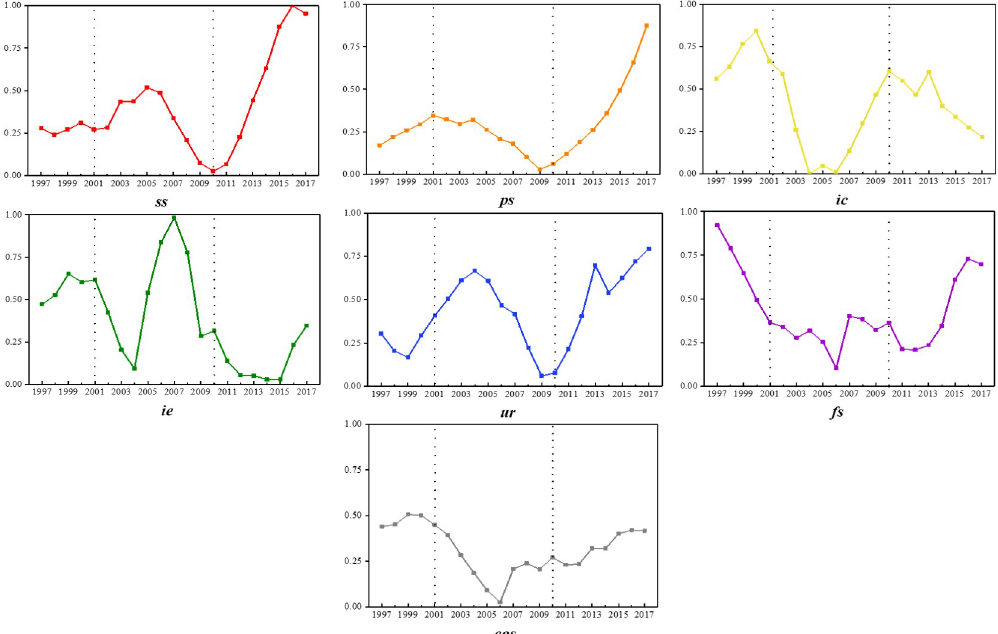
Fig 6. The imbalance index of economic